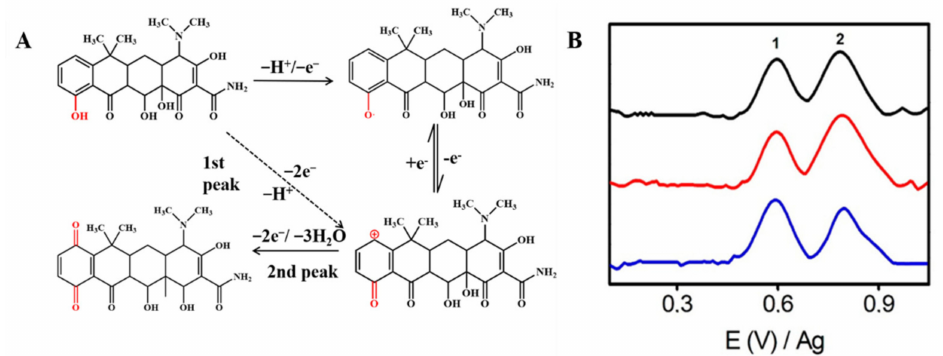
Figure 3. ( A ) Mechanism for the electrochemical oxidation of TET. ( B ) Adsorptive transfer stripping differential pulse voltammograms corresponding to different mixtures of tetracyclines using ErGO. The black, red, and blue lines are different concentrations of the TET antibiotic mixture. Adapted with permission from Ref.